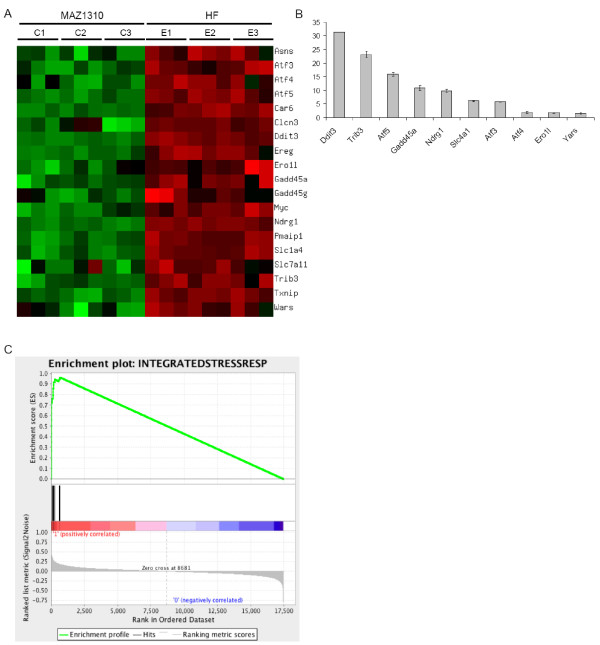
HF upregulates the expression of Integrated Stress Response effector genes. (A) A heat-map of signature genes related to the Integrated Stress Response (ISR) is displayed. Among reported genes in previous studies, nineteen genes were chosen if absolute fold-change was greater than 2 and q-value was less than 0.001. Measurement values were normalized to have mean zero and variance one per gene. The heat-map was generated using matrix2png. (B) Validation of HF induction of selected ISR genes by quantitative RT-PCR (qRT-PCR). qRT-PCR was preformed on an independent set of samples from an 8 hour 0.01 μM HF or MAZ1310 treatment. qRT-PCR data is expressed as the mean fold change in the level of the indicated transcript between HF and MAZ1310 treated samples, and the standard error of the means (SEM) is included. Each condition was assayed in triplicate, and the experiment was repeated three times. Aggregate results are shown. (C) GSEA plot. Enrichment Score (ES) was 0.962 and its nominal P-value < 10-3. top: Enrichment profile where running ES for the Atf4/ISR gene set as the analysis walks along the ranked list; middle: The Hits shows where the members of the Atf4/ISR gene set appear in the ranked list; bottom: Ranked list metric measures a gene's correlation with a phenotype (i.e. Halofuginone treatment).